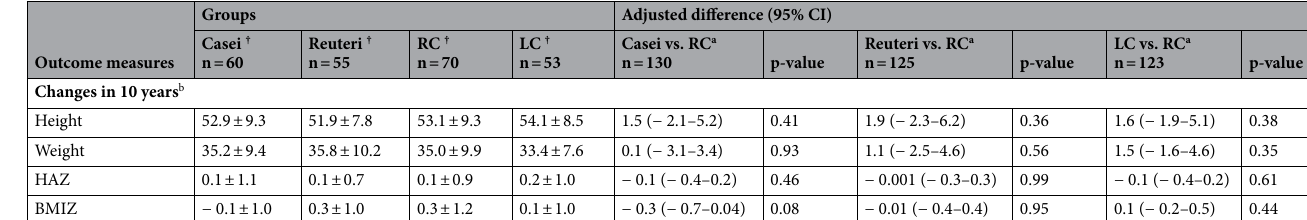
HAZ changes a (n = 238)